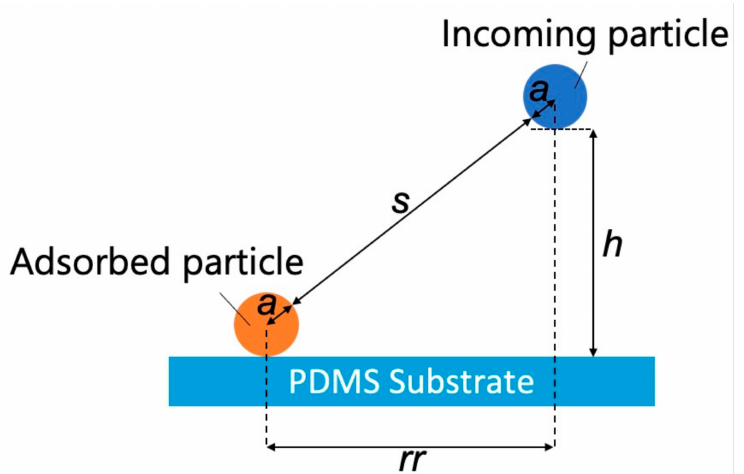
Figure 5. Model representing interactions between an adsorbed particle, an incoming particle, and a polydimethylsiloxane-based substrate ( s : separation between the adsorbed and incoming particles, rr : projected center-to-center distance between the incoming particle and the adsorbed particle, h : separation between the incoming NP and the PDMS-based substrate, and a : particle